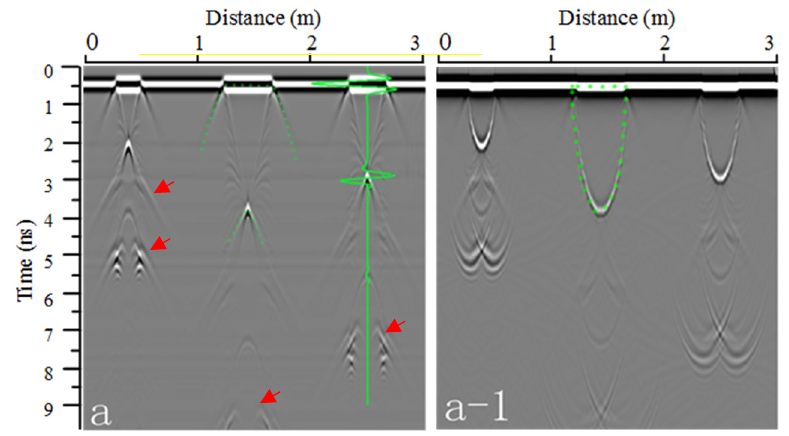
Figure 6. Simulated radargrams of surface SWBs of different sizes: ( a ) The raw radargram; ( a-1 ) the FK migration radargram.